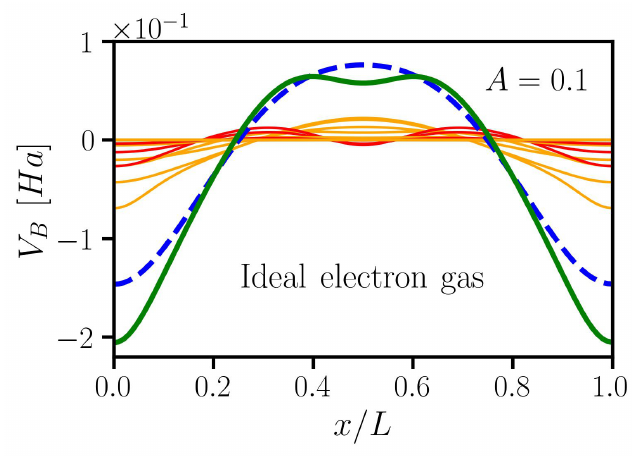
Figure 6: The same as in Fig. 5, but for the non-interacting, i.e., ideal electron gas. dard Bohm potential from the many-fermion quantum Bohm potential in the density depletion regions. As the wave number increases further to q (cid:39) 2.53 q observation is in agreement with the fact that, in the limit q (cid:29) q the single-particle limit — the standard Bohm potential becomes